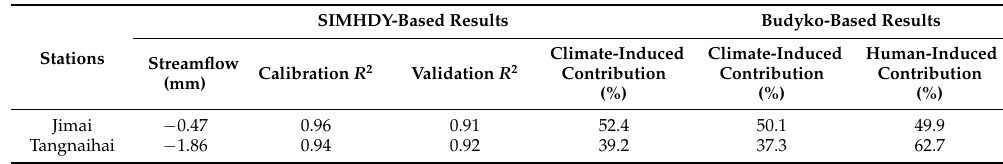
Figure 8. Comparison of simulated and observed monthly streamflow depths during the calibration, validation, and influence periods for the SIMHYD model. Table 2. Comparison between SIMHYD-based results and those obtained by the climate elasticity method for streamflow changes at the Jimai and Tangnaihai stations